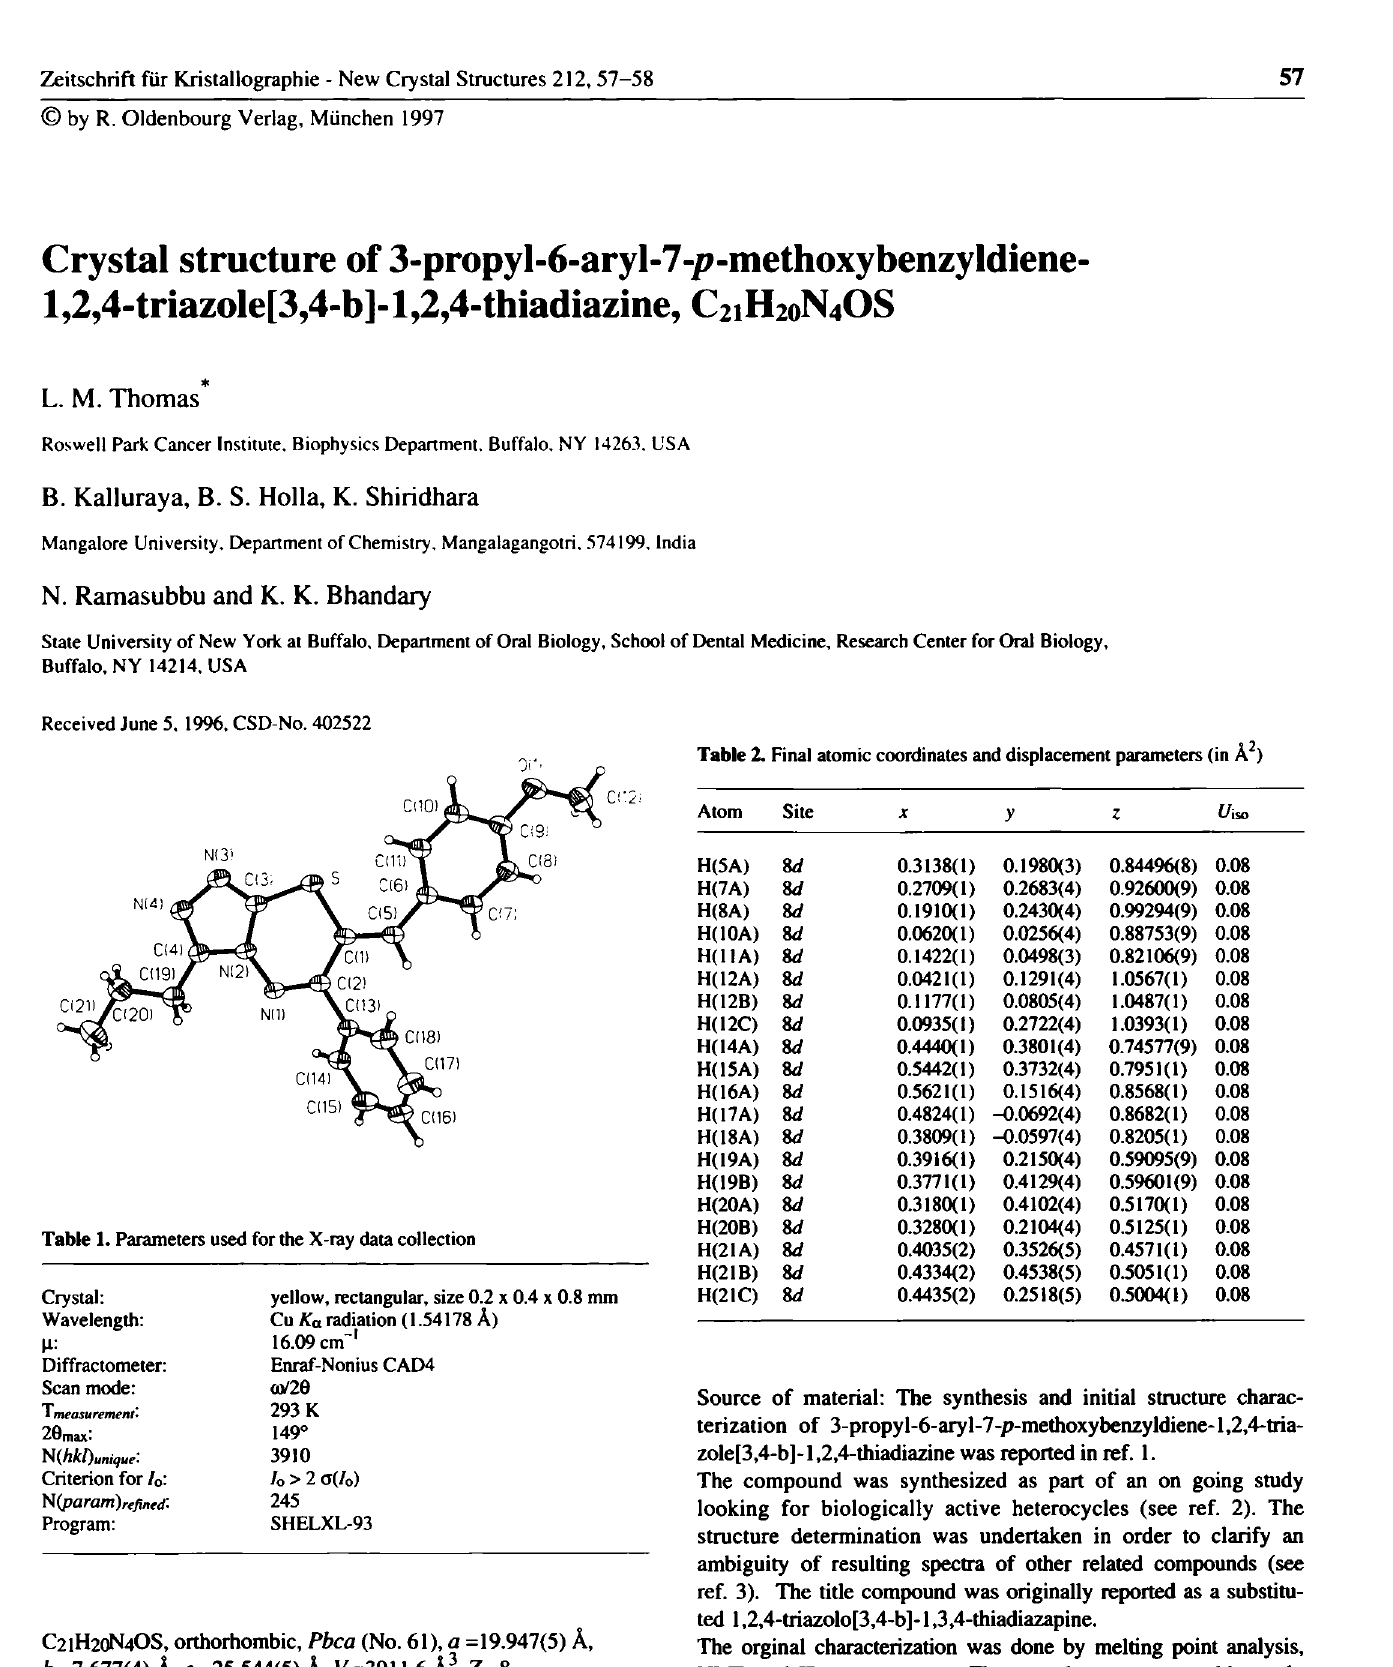
Table 1. Parameters used for the X-ray data collection Crystal: